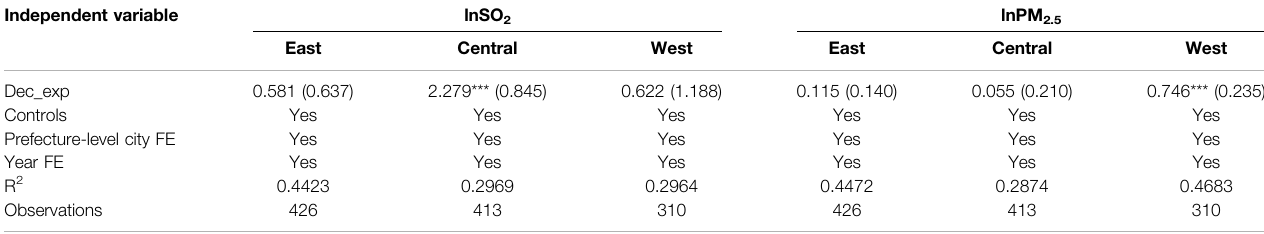
TABLE 6 | Results of the eastern, central, and western regions. Independent variable